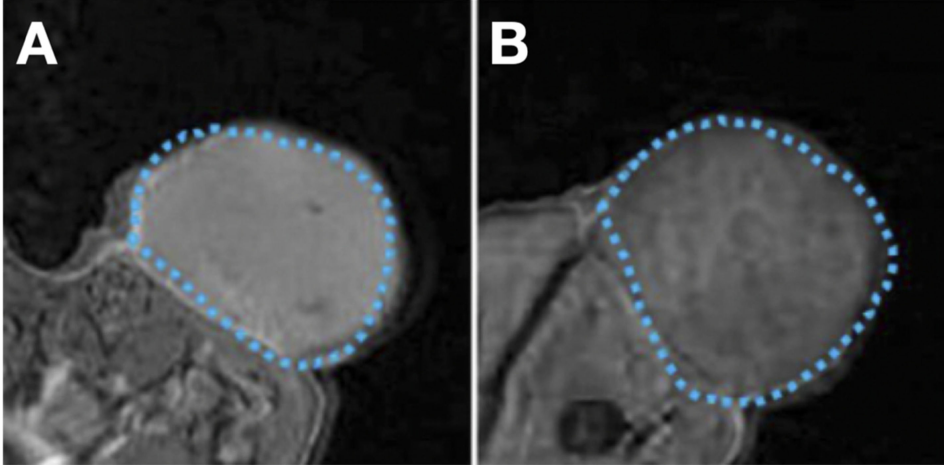
Figure 16. MRI in subcutaneous thyroid squamous cell cancer (TSCC) xenograft (blue dashed line) with NPs-SHP2 nanoparticles after LIFU treatment. ( A ) injection of SHP2-targeted nanoparti- cles. ( B ) injection of non-targeted nanoparticles (control). Reproduced with permission from [155], copyright Dove Medical Press Inc.